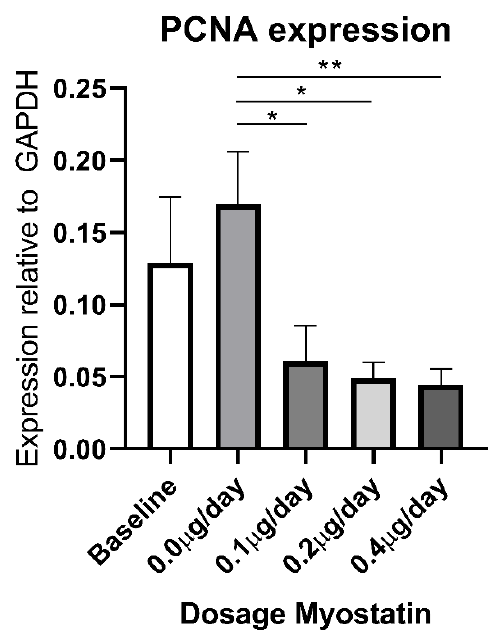
Figure 6. PCNA mRNA expression in femoral arteries of myostatin treated mice. PCNA mRNA expression is significantly lower in myostatin treated groups at all dosages compared to the control group. Mean expression is shown and error bar represents SEM ( n = 8 for 0.0, 0.1 and 0.4 µ g / day myostatin group, n = 6 for baseline and 0.2 µ g / day group). Student’s t-test performed between treated groups and control group with α = 0.05. * p < 0.05, ** p < 0.01.